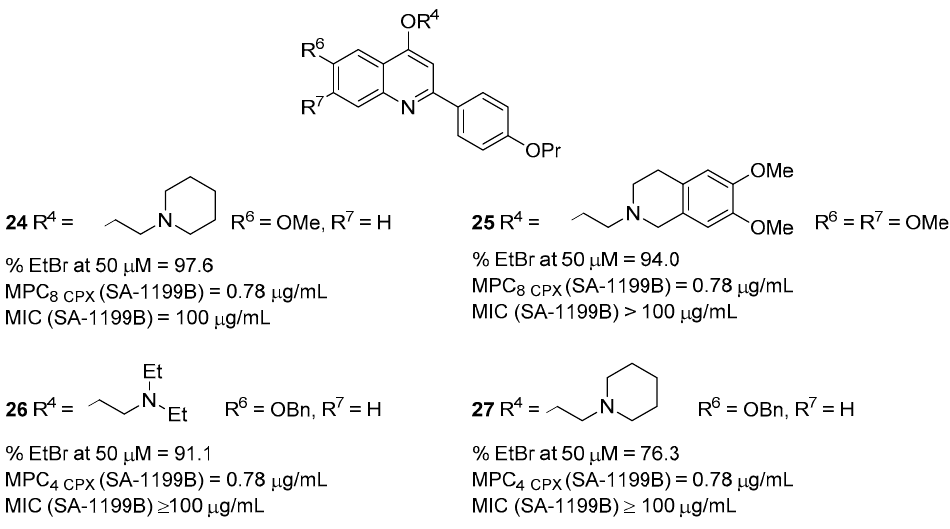
Figure 8. C6-modified O -alkylamino quinolines 24 – 27 as NorA EPIs.